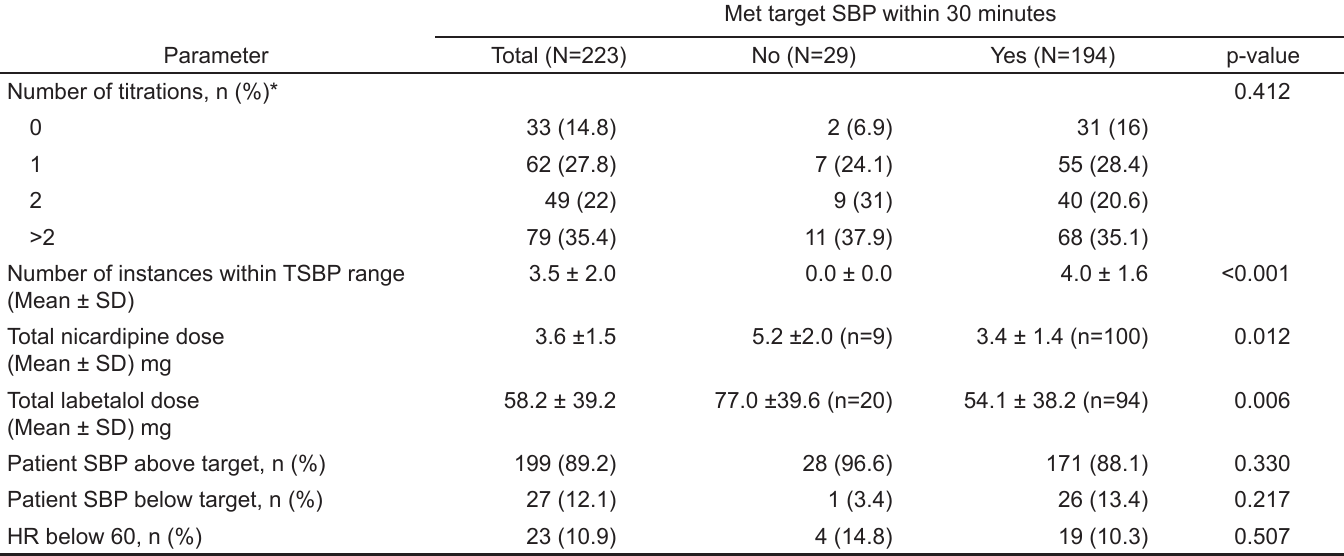
Table 3. Hemodynamic response to treatment in responders versus non-responders.